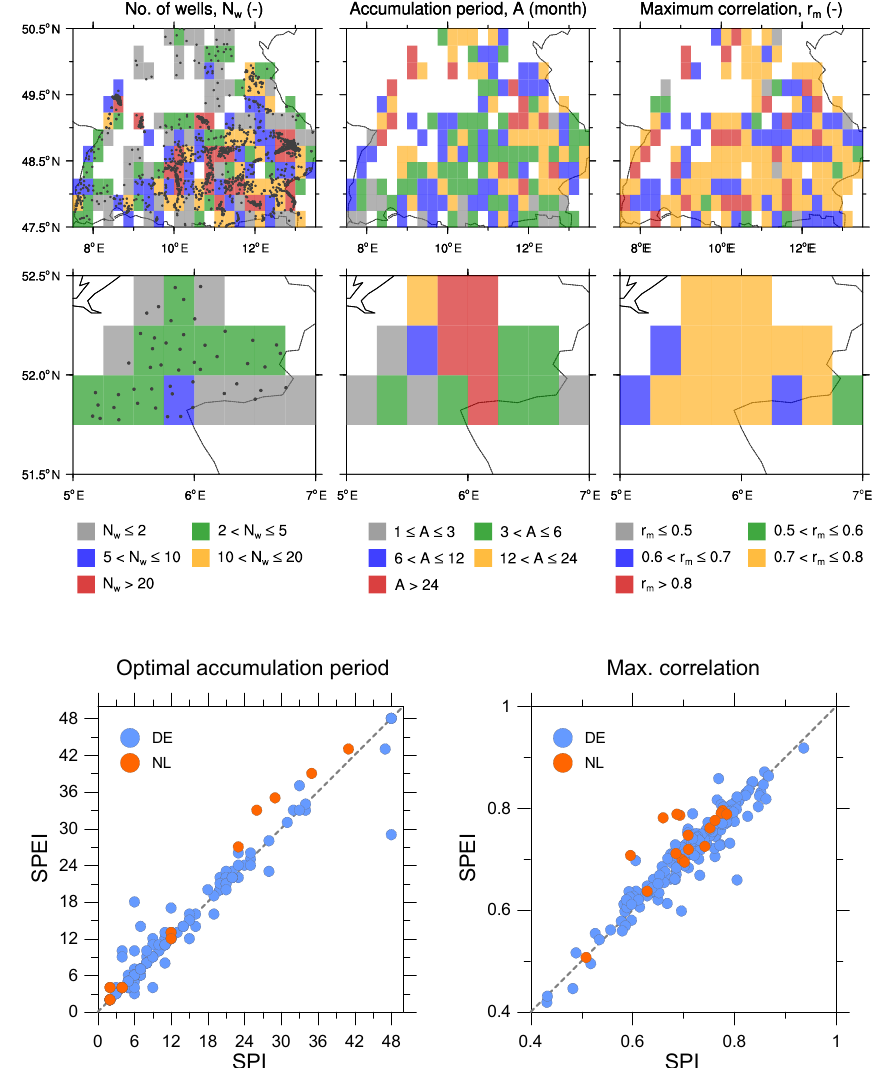
Figure 2. The location of groundwater wells and number of groundwater wells in every 0.25 ◦ grid cell, the optimal accumulation A (month), and the maximum correlation r m ( − ) between the gridded SGI and SPEI for German (top panel) and Dutch (middle panel) datasets. The bottom panels show the correspondence of A and r m estimated from SPI vs. SGI and SPEI vs.